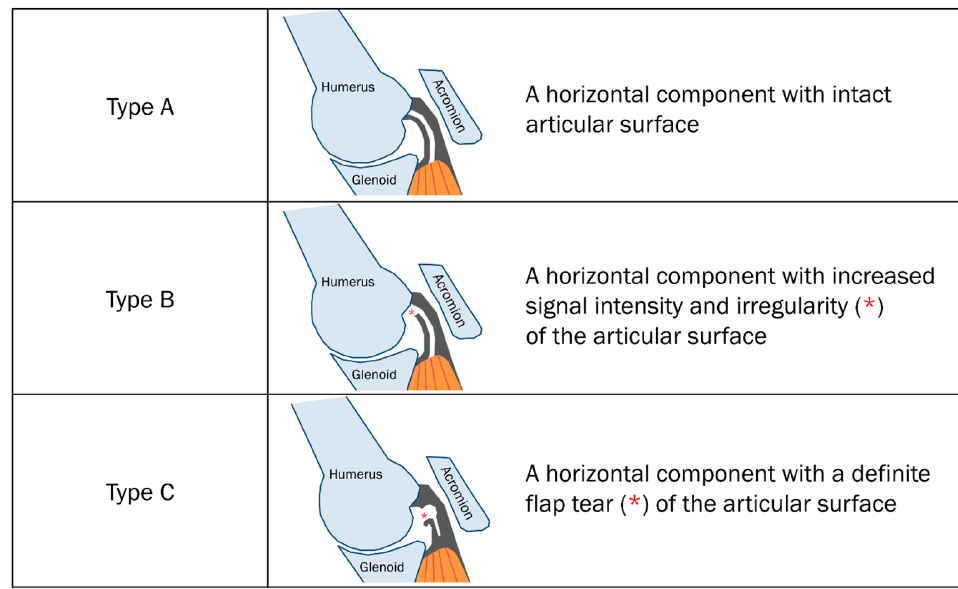
Figure 5. Schematic diagram of the types of delaminated tears of partial-thickness tears by Lee et al. [13].